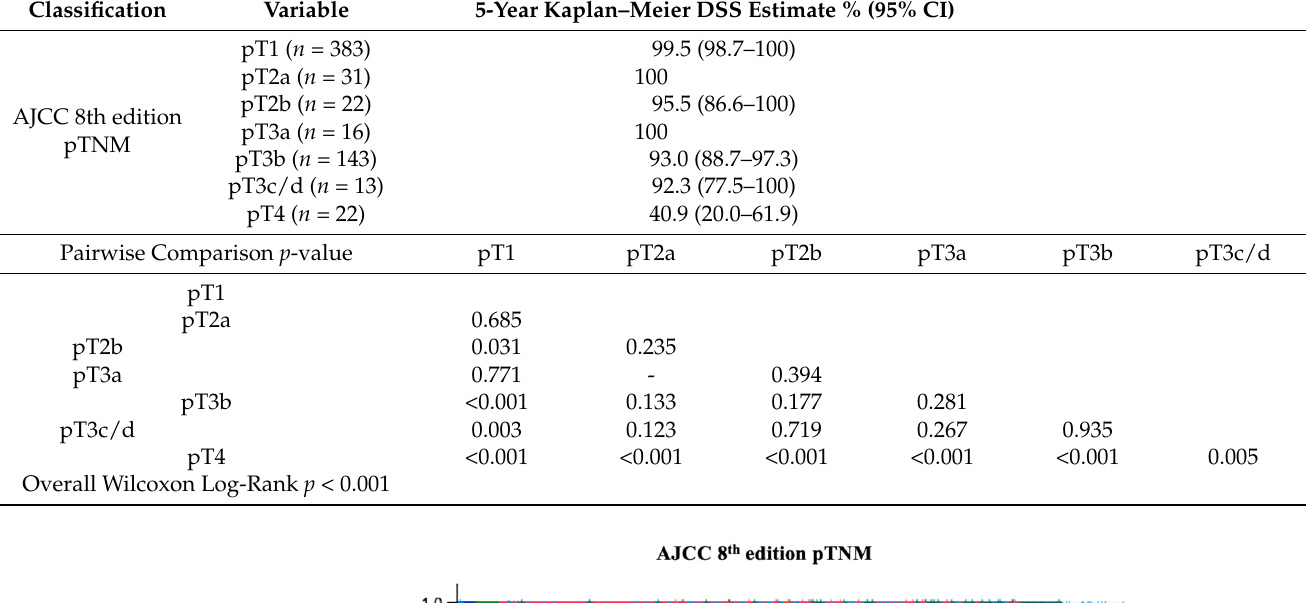
Table 3. Kaplan–Meier Disease-specific Survival Pairwise Comparison for AJCC Pathological Staging.